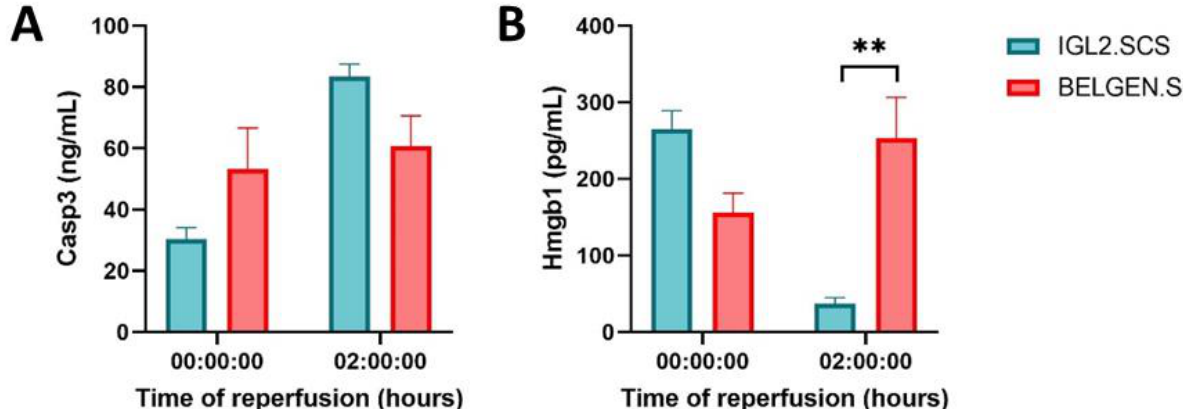
Figure 4. Expression of apoptosis-related marker active caspase 3 and inflammation marker HMGB1 in the perfusate during reperfusion following 24 h of SCS and 2 h of HOPE. ( A ) We observe no significant difference in the caspase 3 levels at T0 and T120. ( B ) HMGB1 ( p < 0.01) is significantly less expressed in the IGL2 group after 2 h of reperfusion. n = 6/group . ** = p < 0.01.